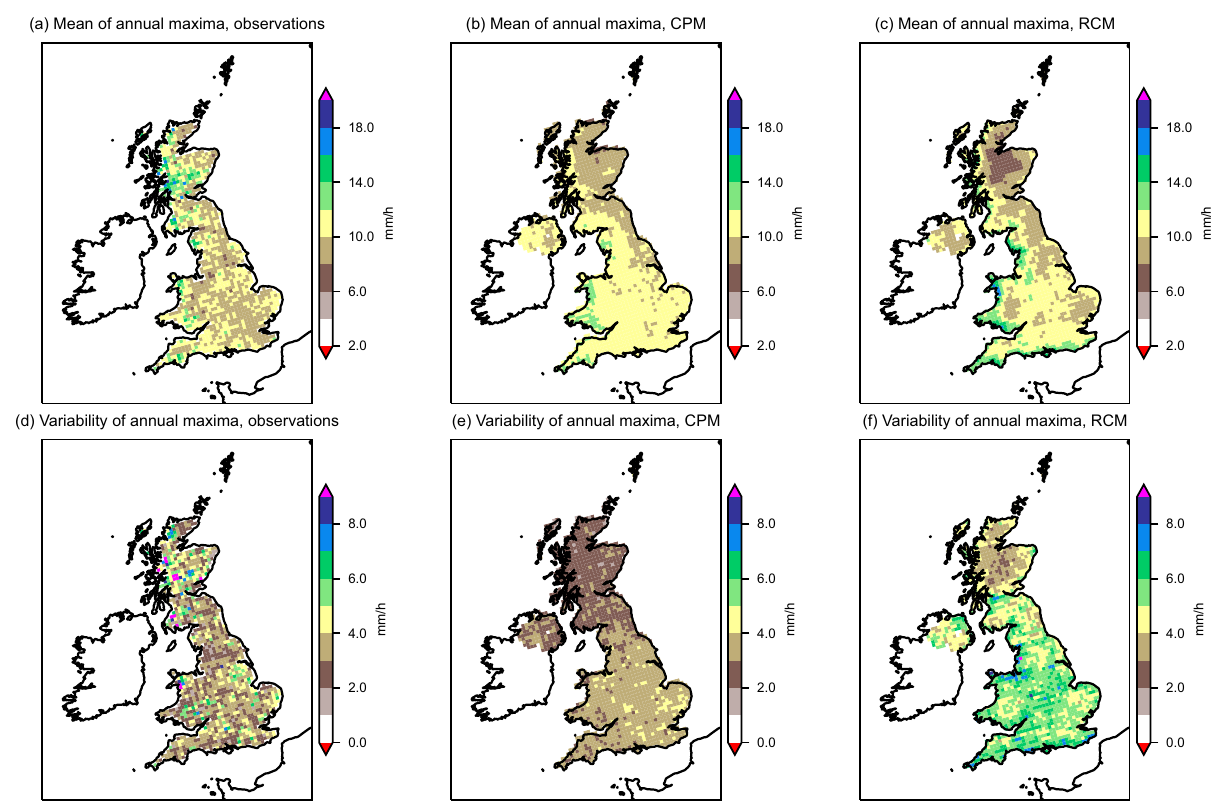
Fig. 2 | Model performance in representing local maximum hourly precipita- tion intensity. Present-day a – c mean and d – f standard deviation of annual max- imum hourly precipitation at every 12km grid box, for 1991 to 2014. Results are